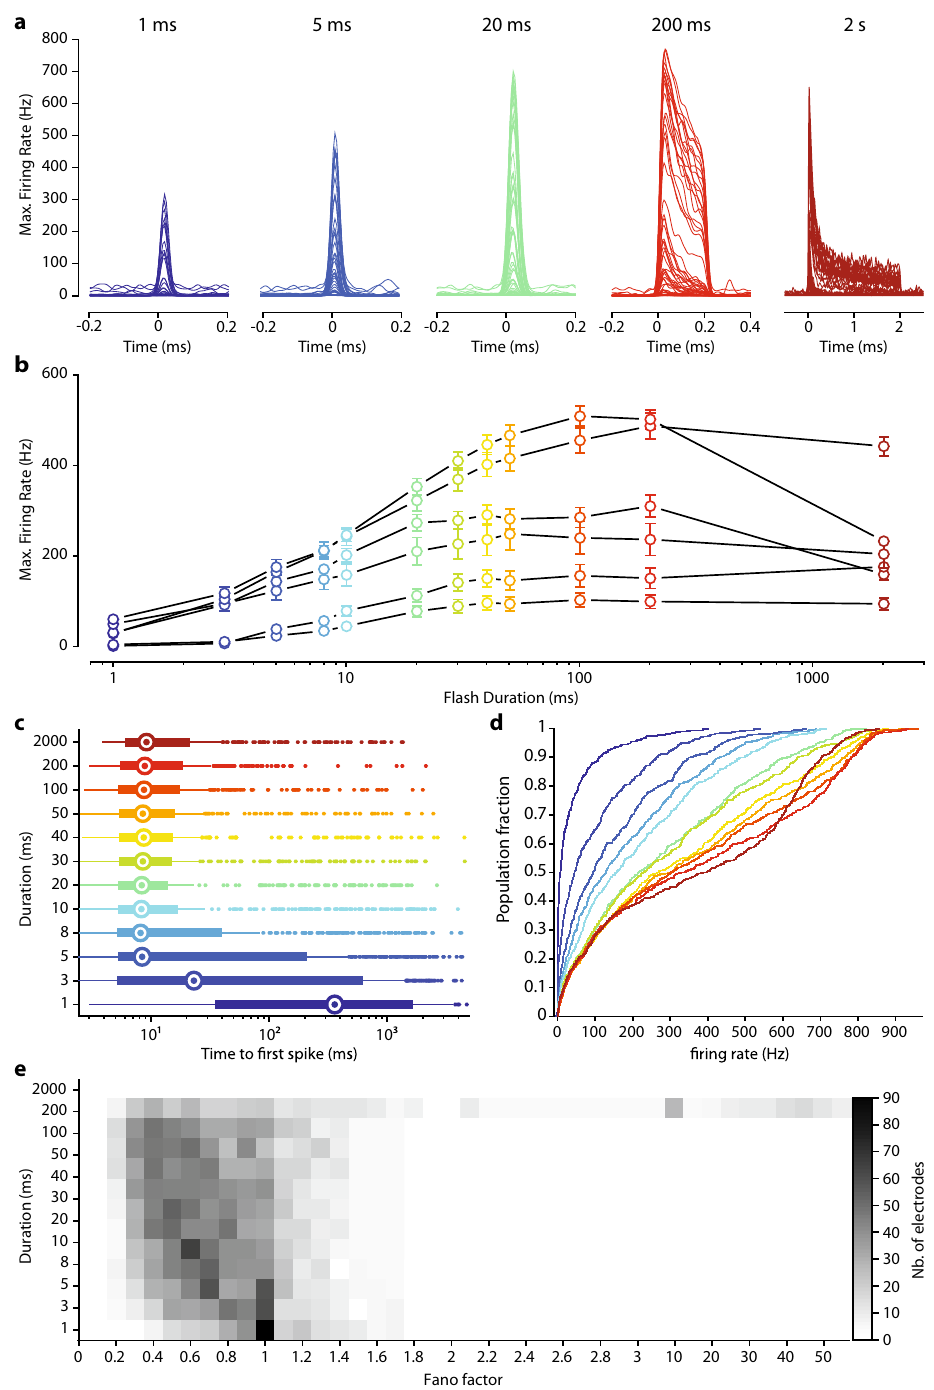
Fig. 3 Millisecond activation of ChR-tdT-expressing primate RGCs. a Spike density function for all responsive electrodes ( n = 66) of one retina treated with for 5 × 10 11 vg in response to stimuli of increasing duration (1 – 5 – 20 – 200 ms, and 2 s, left to right with different colors) and constant light intensity (2 × 10 17 photons cm − 2 s − 1 , 600 nm ± 10 nm). b Mean maximal fi ring rate ± SEM measured for retinas treated with 5 × 10 11 vg/eye for all tested stimuli duration and constant light intensity ( n = 6). c Horizontal box plot displaying time from the onset of stimulation to the fi rst spike, as a function of stimulus duration. Recordings from the different retinas are pooled, such that each electrode has the same weighting. Medians are displayed as an open circle, box edges indicate the 25th and 75th percentiles, whiskers extend to the maximum and minimum, and outliers are plotted individually. d Cumulative plot of maximal fi ring rate per electrode versus stimulus duration, with duration color-coded as in c . e Distribution of Fano factor as a function of stimulation duration, for all responsive electrodes. A value of 1 corresponds to the Poisson distribution, and values below 1 indicate an increase in information content ( c , d , e : n = 488 electrodes from six retinas expressing